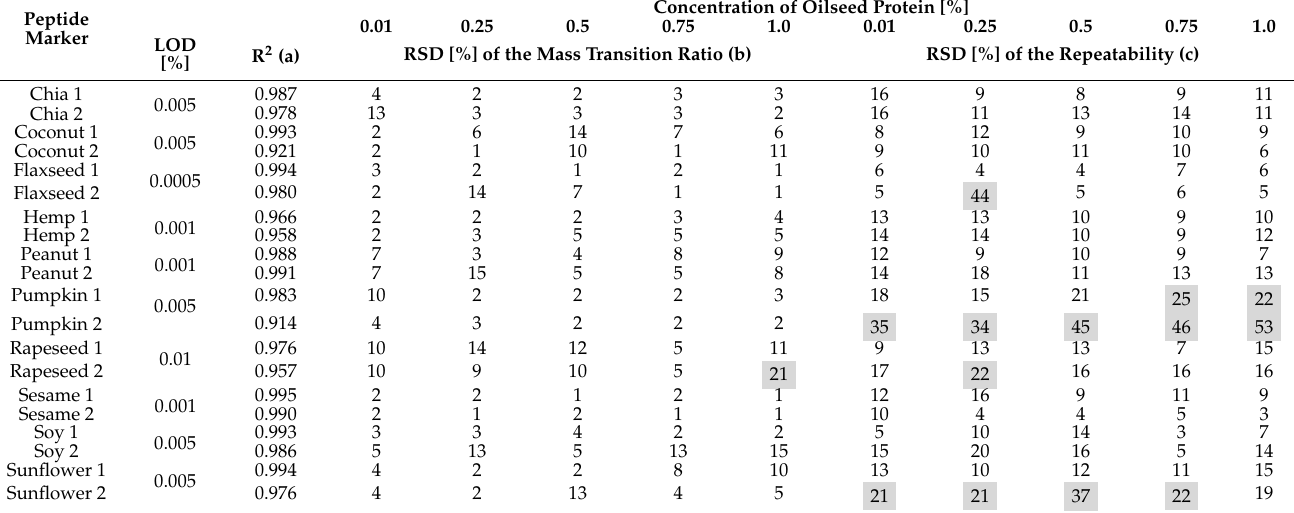
Table 3. Limits of detection (LOD), mean coefficients of determination (R 2 ) of the regression between the concentration of oilseed protein and the peak area of the peptide markers (a) (N = 6, each), and relative standard deviations (RSD) of the ratio of the lowest to the highest intensive mass transition each (b), and the repeatability of the peak area at varying concentrations of oilseed protein in the standard sausages of processing series 2 (c) as criteria for the suitability of the peptide markers for the quantification; gray marking = RSD ≥